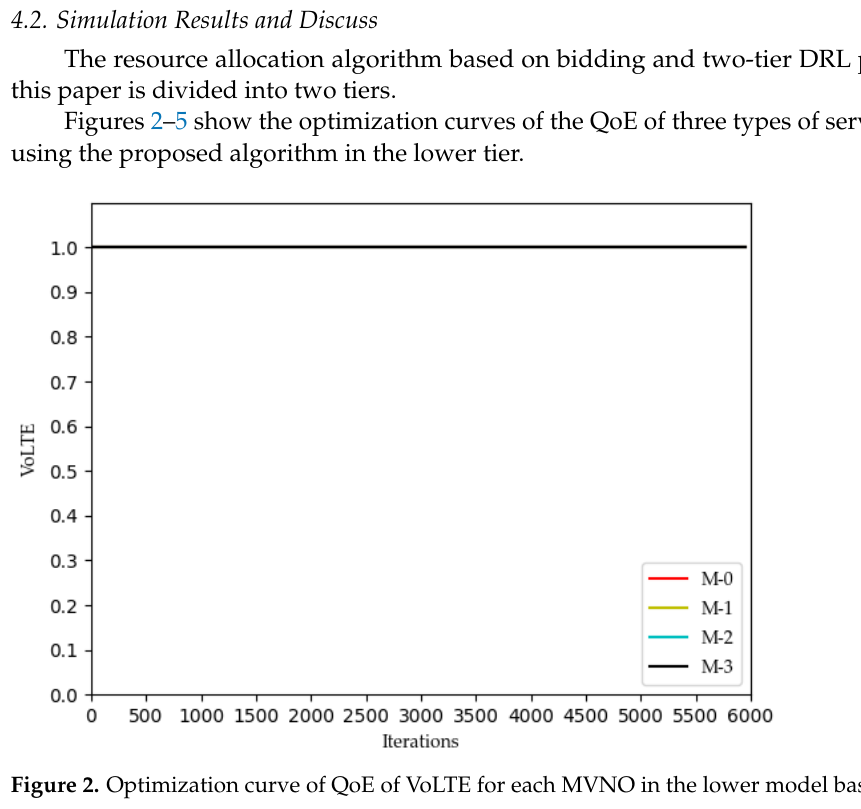
Figure 3. Optimization curve of QoE of URLLC for each MVNO in the lower model based on DQN.